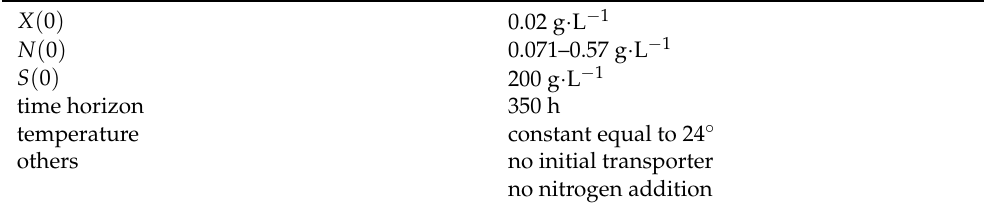
Table 1. Operating conditions for the simulation of the model with transporters.